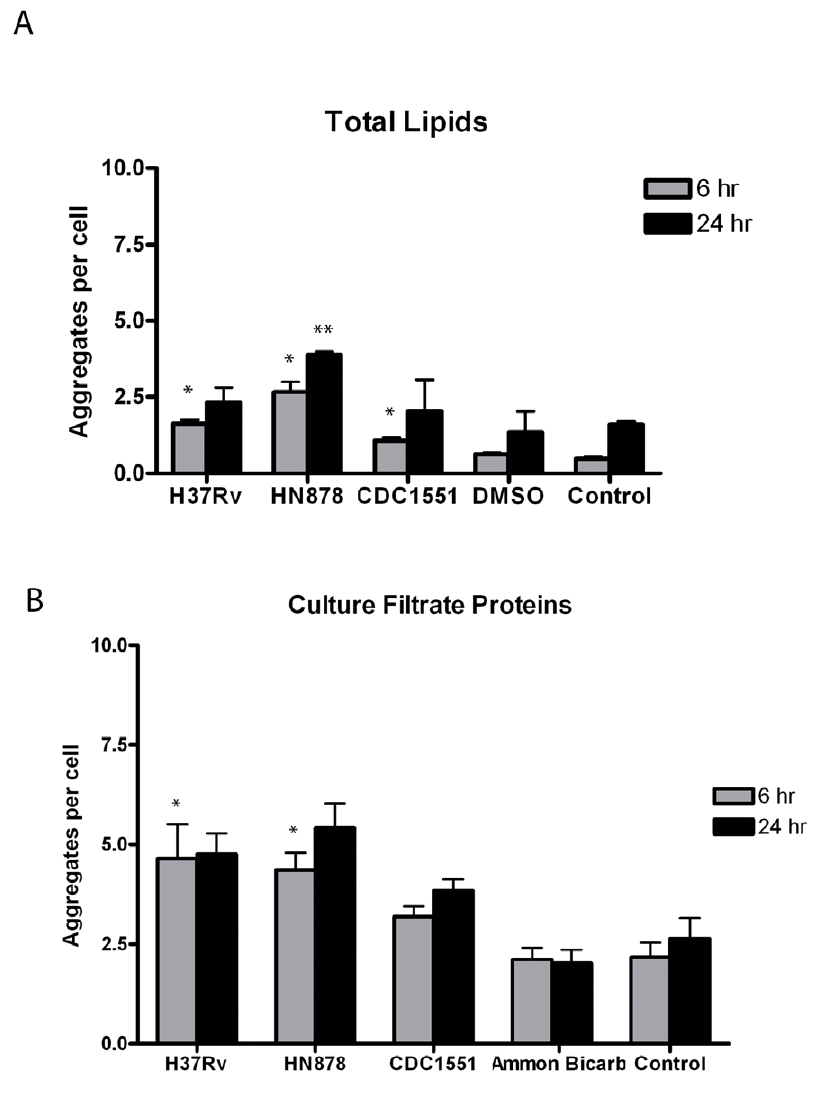
Figure 3. Treatment of A549 cells with total lipids or culture filtrate proteins from Mtb strains produces limited LR aggregation. A549 cells treated with total lipids (TL) or culture filtrate proteins (CFP) from all three strains were processed for confocal microscopy at 6 and 24 hr post-treatment as described. At 6 hr post-treatment, a significant increase in LR aggregation was observed in TL treated A549 cells compared to uninfected controls (*p-value , 0.05) (A). At 24 hr post-treatment HN878 TL produced significantly higher aggregate numbers compared to uninfected controls (**p-value , 0.001) (A). It should be noted that LR aggregation for HN878, CDC1551 and H37Rv at 24 hr post-treatment was not significantly different from uninfected and DMSO controls (p-value 0.065, 0.977 and 0.737, respectively) (A). Compared to controls, treatment with CFP from CDC1551 did not produce statistically different LR aggregation values at 6 and 24 hr post-treatment (p-value=0.598 and 0.379, respectively) (B). LR aggregation for HN878 and H37Rv was significantly different from controls at 6 hr post-treatment (*p-value=0.033 and 0.012, respectively) (B). Experiments were performed in triplicate and repeated three times. A total of 15 fields were imaged per coverslip, incorporating approximately 30–50 host cells per field. Data presented are the average of three experiments. Images to obtain LR data were captured at